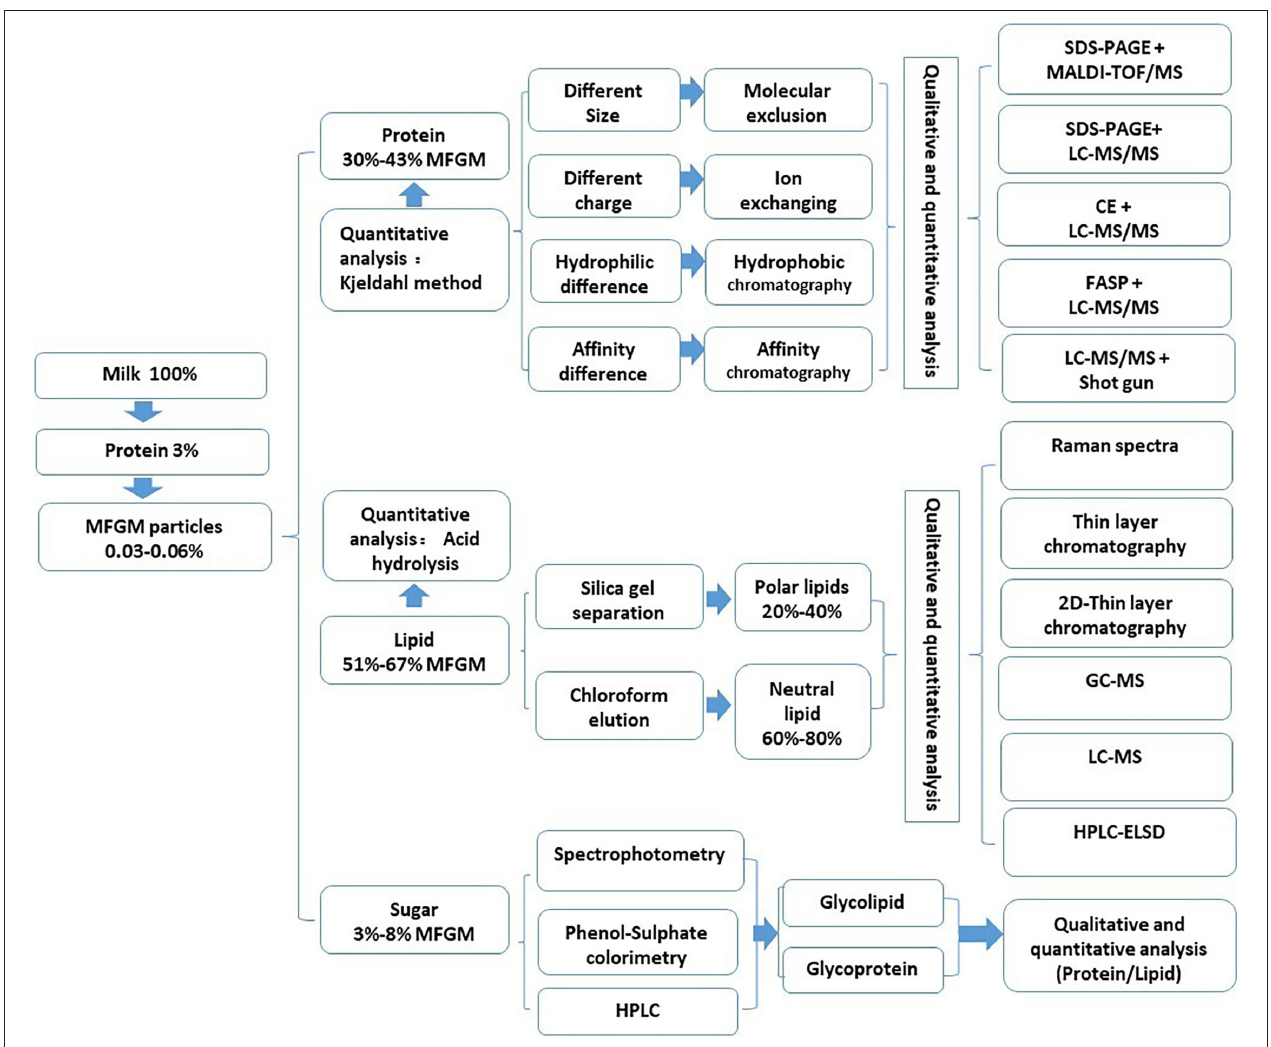
FIGURE 2 | Identification and the quantitative analysis of the components in